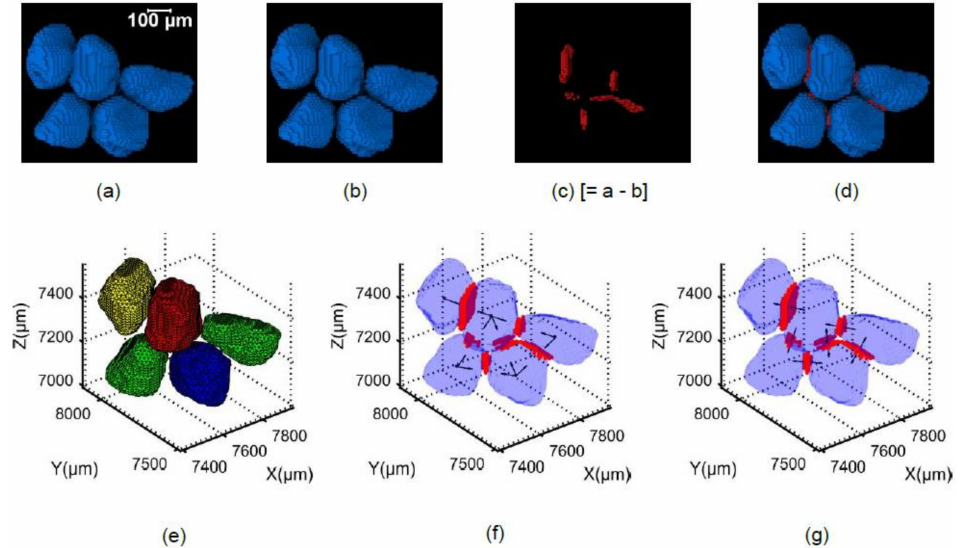
Figure 4. Demonstration of steps involved in determining coordination number, branch vector and contact normal vector: ( a ) unseparated binary particles; ( b ) separated binary particles; ( c ) contact voxels; ( d ) particles with contact voxels; ( e ) coordination numbers (yellow-1, green-2, blue-3, red-4); ( f ) branch vectors; ( g ) contact normal